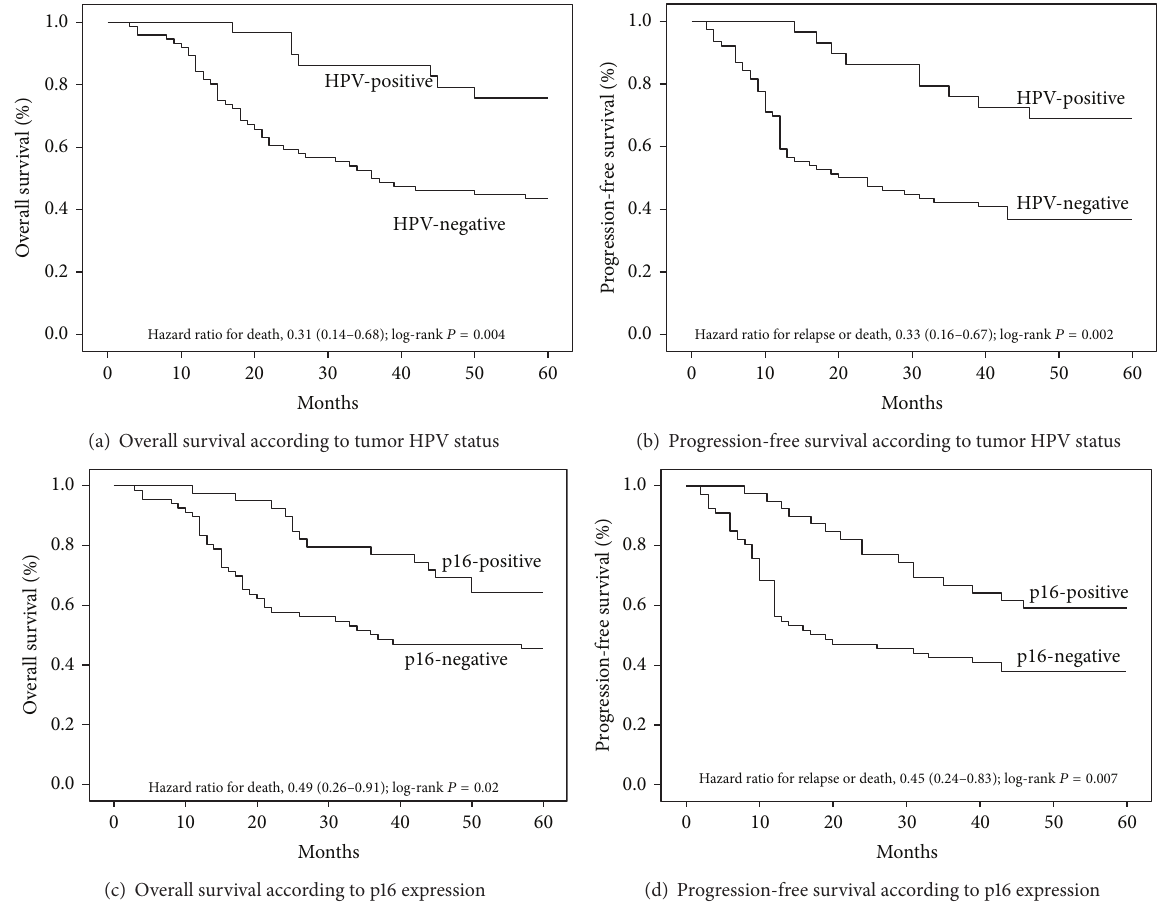
Figure 2: Kaplan-Meier estimates of survival among the study patients, according to tumor HPV status or p16-expression status. For 5-year overall survival rate (a) and 5-year progression-free survival rate (b), HPV was significantly associated with improved outcomes ( 𝑃 = 0.002 , 𝑃 = 0.001 , resp.). For 5-year OS rate (c) and 5-year progression-free survival rate (d), p16 was significantly associated with improved outcomes ( 𝑃 = 0.021 , 𝑃 = 0.007 ,